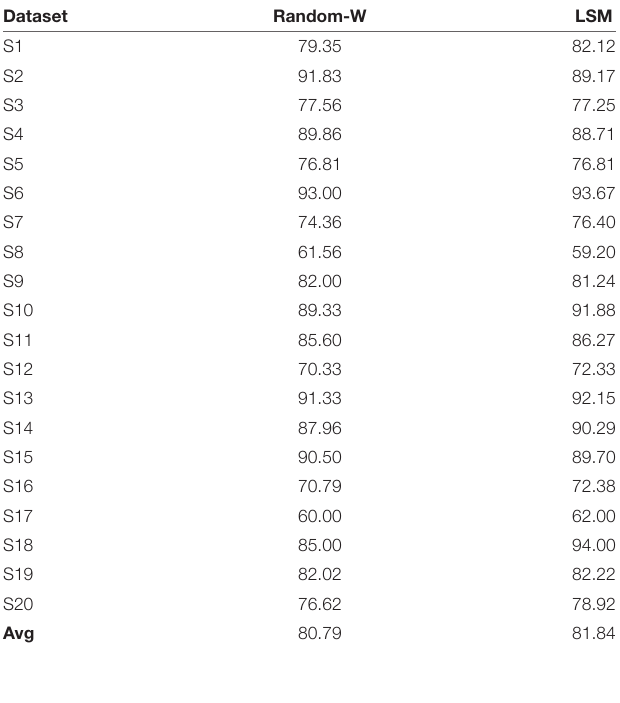
TABLE 4 | Comparison of classification performance of ERN dataset via NVB for transformed signal with random weight and LSM. Dataset